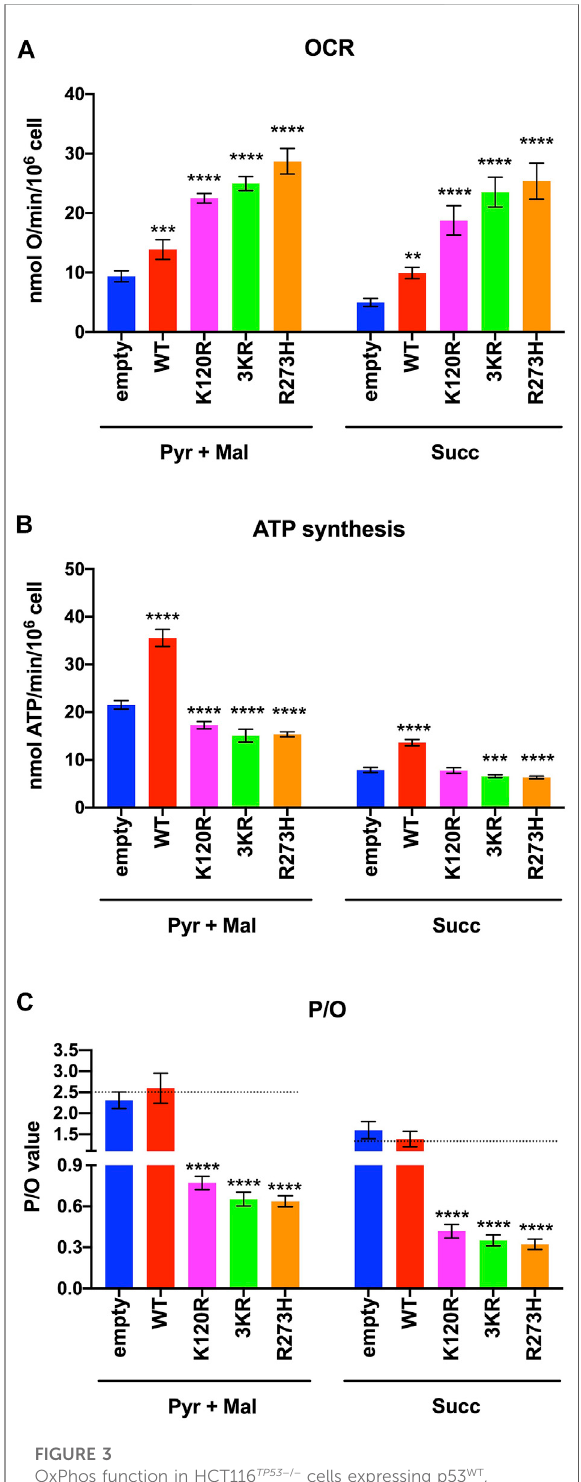
FIGURE 3 OxPhos function in HCT116 TP53 − / − cells expressing p53 WT , p53 3KR , p53 K120R , and p53 R273H proteins. (A) OCR in the presence of Pyruvate (Pyr) plus Malate (Mal) or Succinate (Succ). (B) ATP synthesis through the F o -F 1 ATP synthase in the same condition as above. (C) OxPhos ef fi ciency as P/O ratio in the